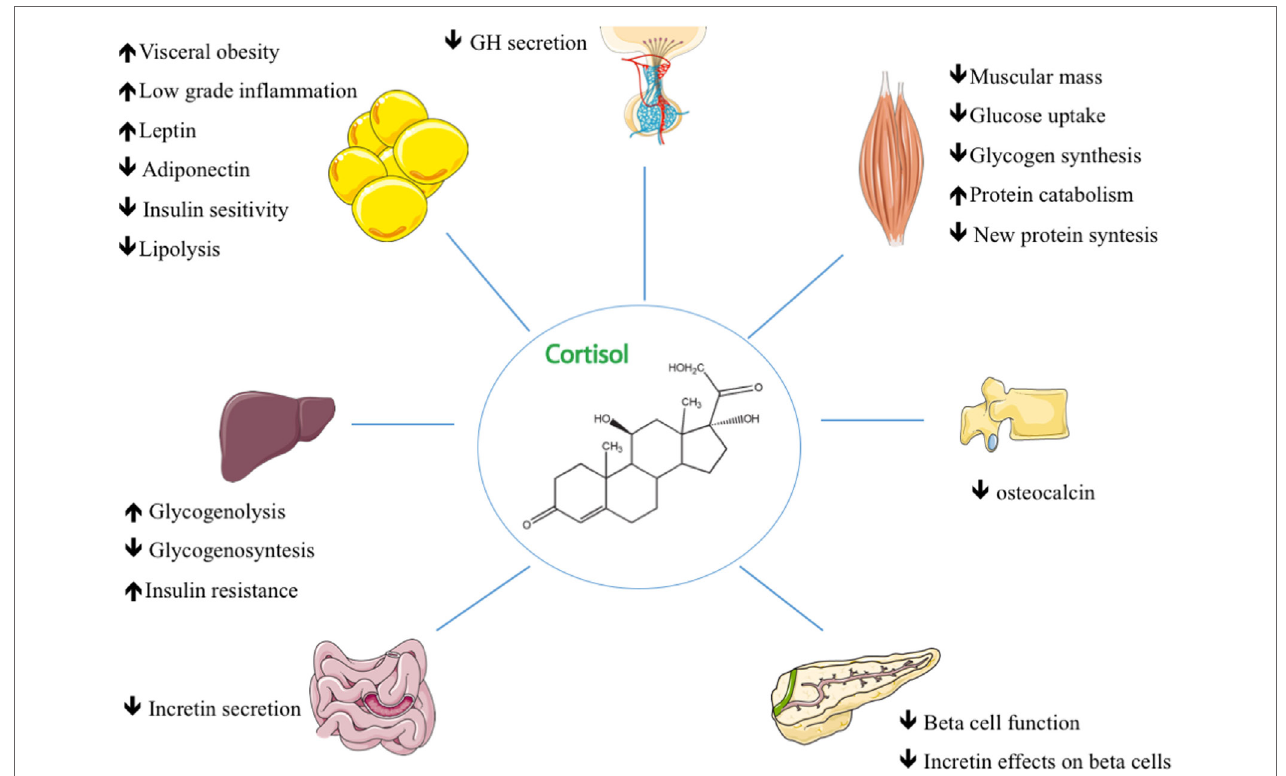
FiGURe 1 | The main mechanisms of action in glucocorticoid-induced diabetes and their effects on target tissues in Cushing’s